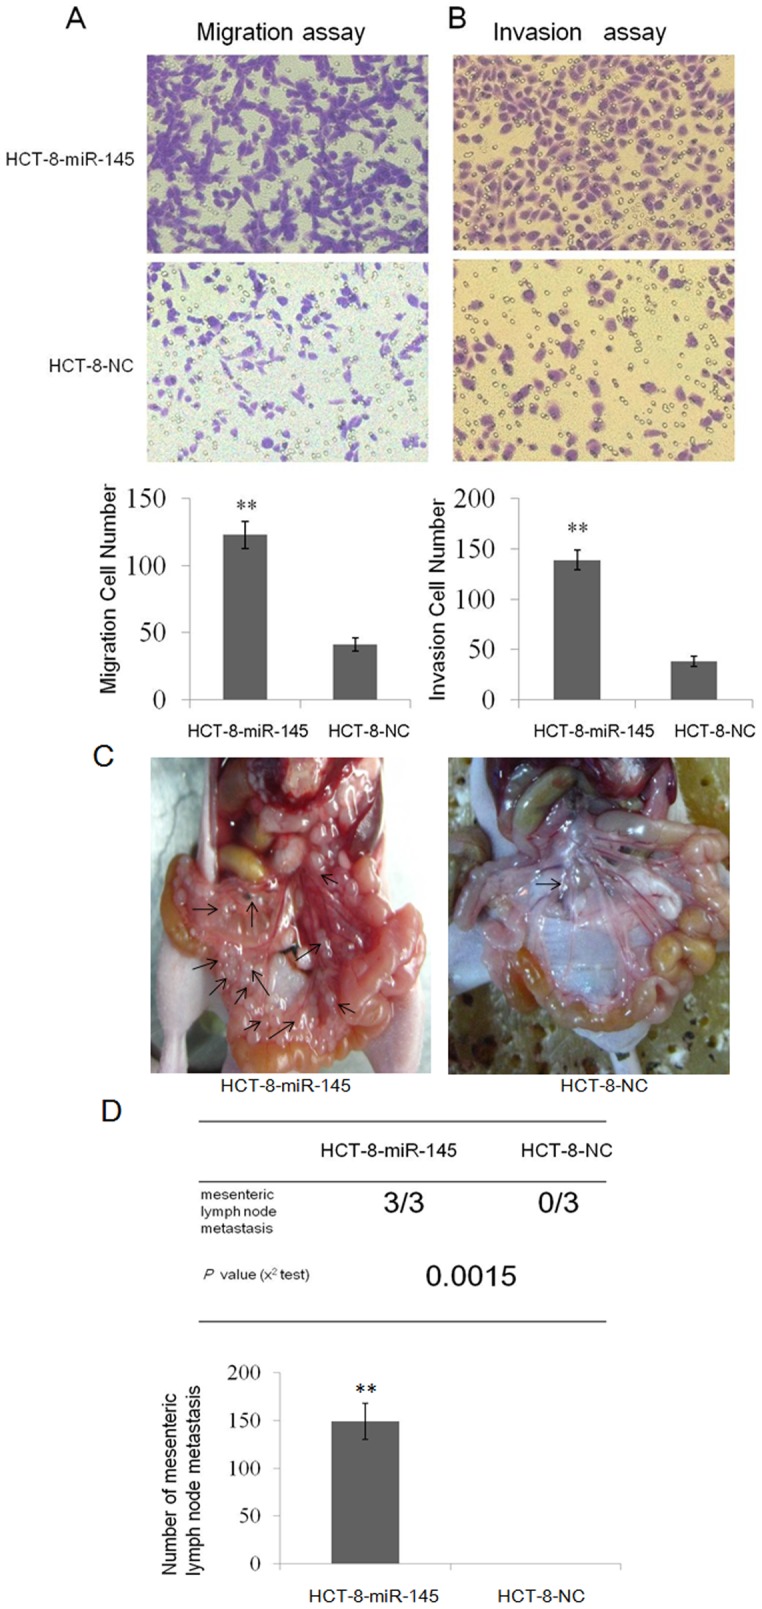
MiR-145 promoted invasion and metastasis of CRC cells in vitro and in vivo.
(A) Migration and invasion (B) assay of HCT-8-miR-145 or HCT-8-NC cells. The images were representatives of at least three independent experiments. Average number of migration cell number per field from at least three independent experiments ± SD is shown by column figure. ** P<0.01. (C) Photo images of mesenteric lymph node metastasis from nude mice which was injected into the liver with HCT-8-miR-145 or HCT-8-NC cells followed by surgical suture. Animals were killed 2 weeks post intra-hepatic cell inoculation. (D) Incidence of mesenteric lymph node metastasis in mice (table) and mean number of visible metastatic nodules in mesentery (column figure). ** P<0.01.